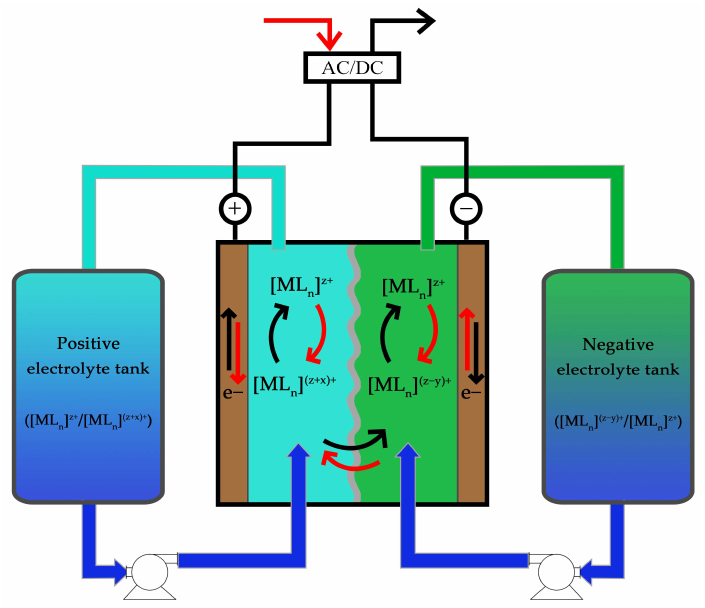
Figure 6. Schematic diagram of a NA-RFB.